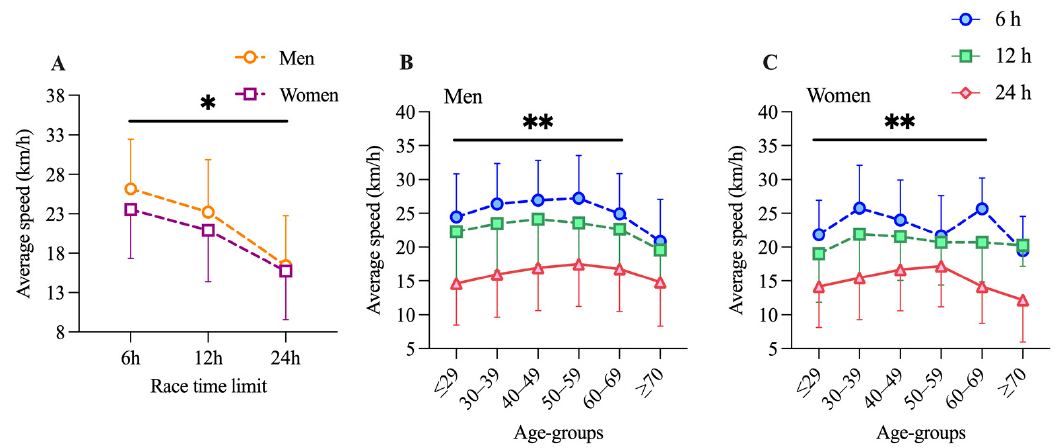
Figure 2. Average speed (km/h) of men and women ( A ). Average speed (km/h) of men ( B ) and women ( C ) subdivided into 6, 12, and 24 h races and age groups. Data expressed as mean and standard deviation. * difference between men and women for each distance below the line. ** difference between race distances for each age group below the line.